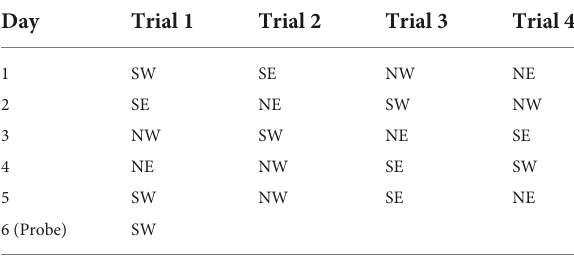
TABLE 1 Summary of the starting position of each training (hidden platform located at